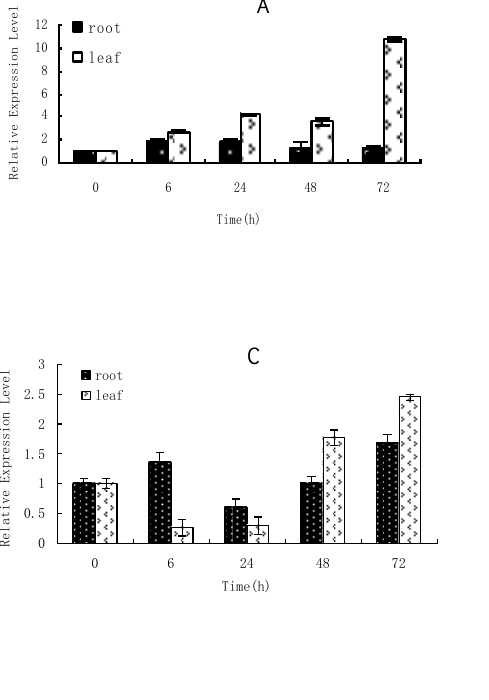
stress; C : 150 µM 2